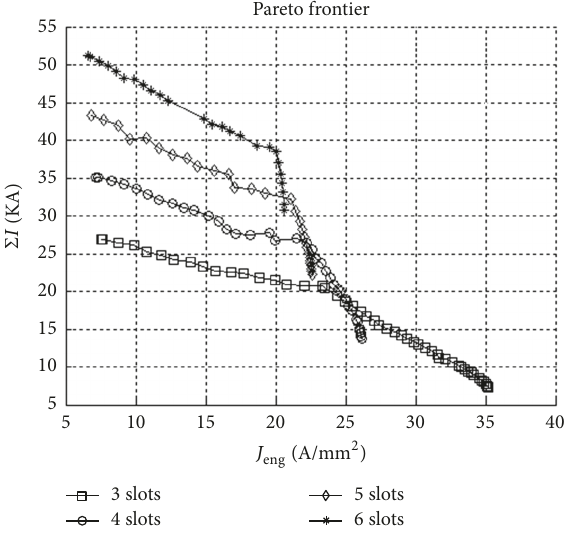
Figure 6: Pareto frontier, in the objectives domain, representing the full set of optimal solutions found for 3, 4, 5, and 6 slots’